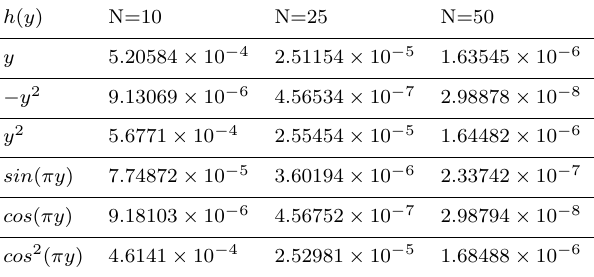
solutions on the interval